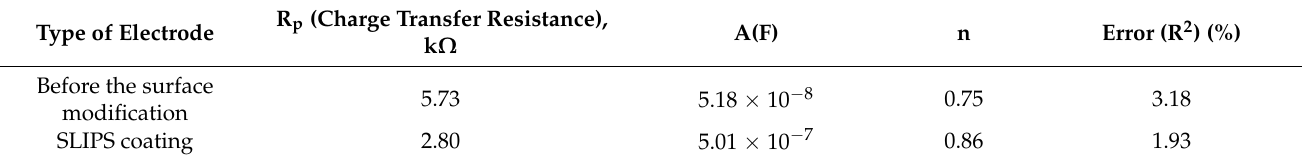
Figure 7. Equivalent circuit of the electrode – electrolyte for ( a ) bare electrode or before the surface modification of the electrode and ( b ) the SLIPS-coated electrode. modification of the electrode and ( b ) the SLIPS-coated electrode. Table 2. Fitting parameters from the EIS model. Table 2. Fitting parameters from the EIS